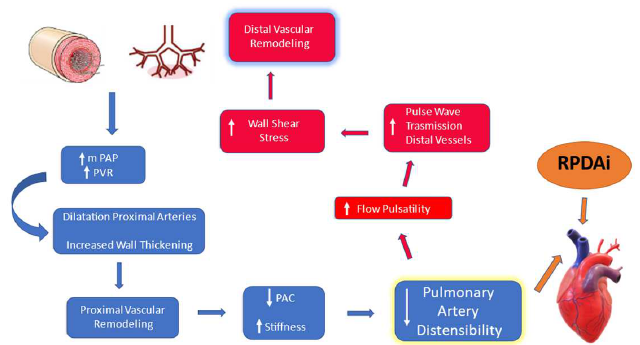
Figure 1. Schematic representation of the interrelationship loop between peripheral vascular dis- ease and modification of pulmonary distensibility. mPAP, mean pulmonary artery pressure; PVR, pulmonary vascular resistance; PAC, pulmonary arterial compliance.